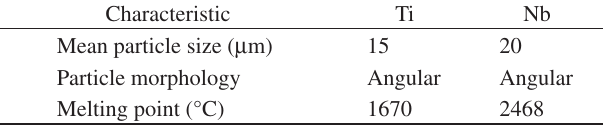
Table 1. Characteristics of the powders used in the Ti-35Nb alloy prepara- tion. Characteristic